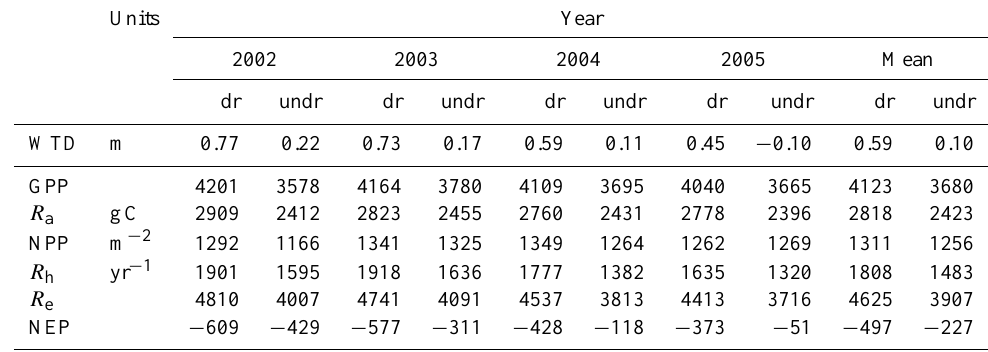
Table 4. Sensitivity of modelled annual C balance to drainage over a drainage affected tropical peat swamp forest at Palangkaraya, Indonesia ∗ . Units